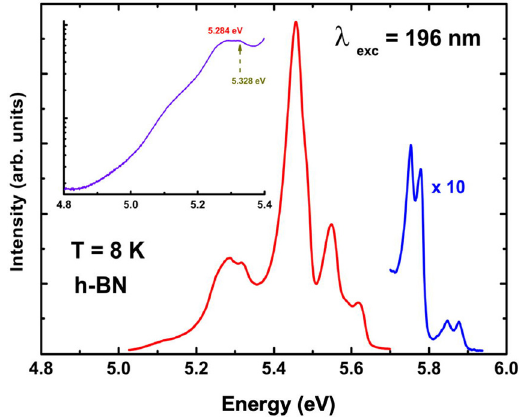
Figure 11: Low temperature photoluminescence spectrum of BN plotted in the 4.8 – 6.0 eV range. Blue plot: phonon-assisted tran- sitions, red plot phonon assisted overtones recombinations to stacking faults and a PL bands at 5.55 and 5.3 eV. Insert: the 5.3 eV region showing the composite nature with a broad line and the lowest energy of the overtones recombinations to stacking